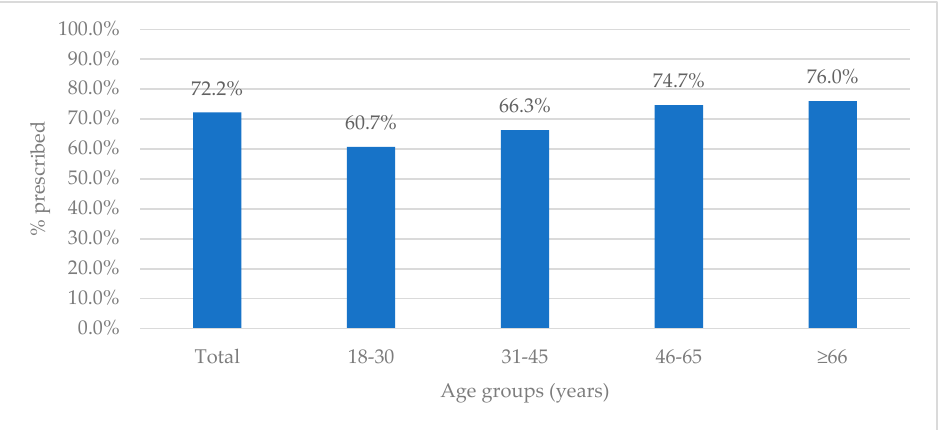
Figure 3. Antibiotic prescribing upon admission across age groups .